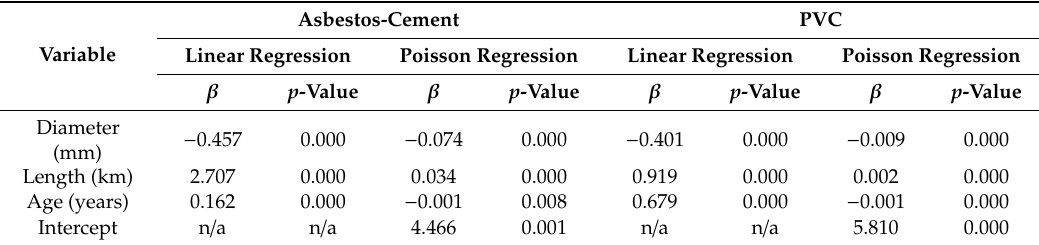
Table 3. Results for Linear and Poisson